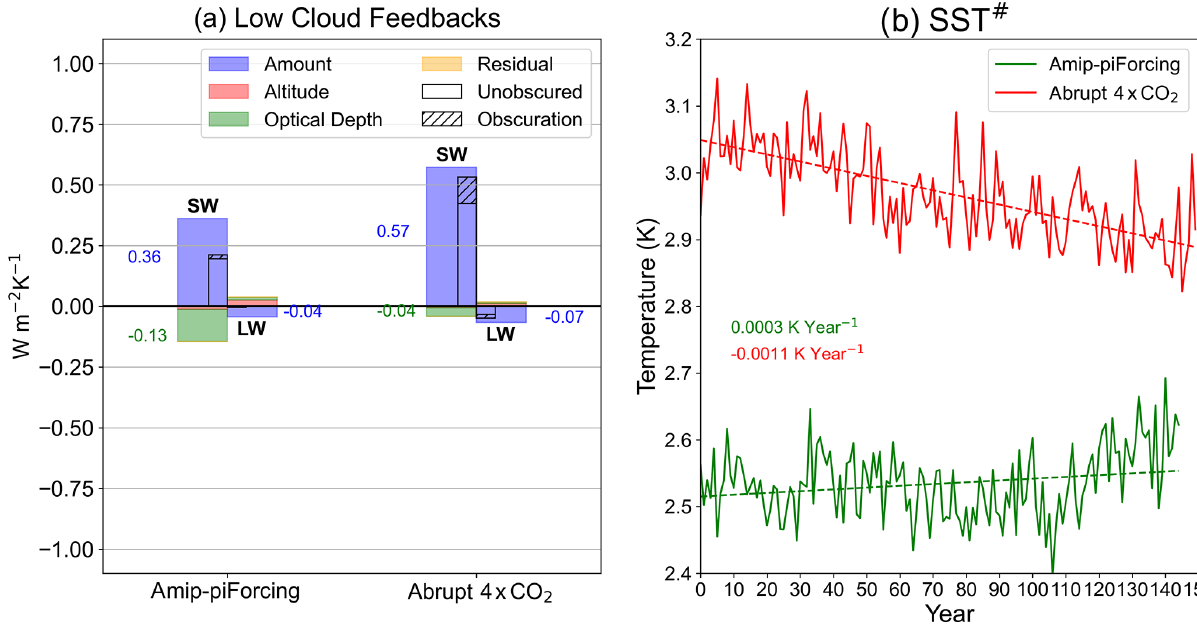
Figure 6. (a) Global annual mean decomposed cloud feedbacks for CanESM5’s AMIP-piForcing and abrupt 4 × CO 2 experiments. Feedbacks are partitioned into both LW and SW contributions from cloud amount (blue), cloud altitude (red), optical depth (green), and residual (orange) terms. Feedbacks are also separated into non-obscured and obscuration terms, shown black bars. For contributions smaller than 0.01Wm − 2 K − 1 , text values were omitted for the sake of clarity. (b) Annual mean time series of SST # for both CanESM5